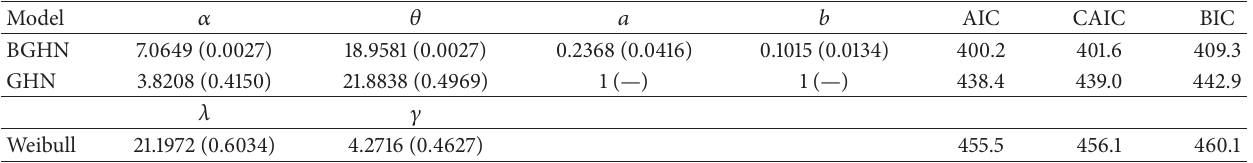
Table 4: MLEs of the model parameters for the USS Halfbeak diesel engine data, the corresponding SEs (given in parentheses), and the AIC, CAIC, and BIC statistics.